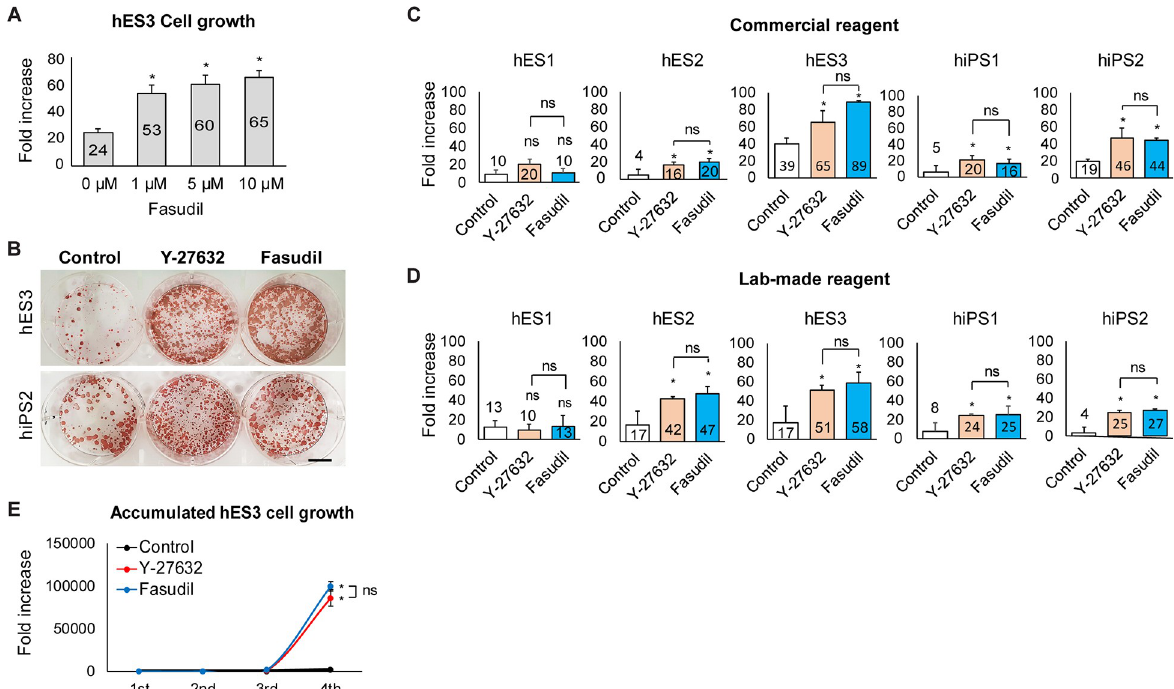
Fig 2. Fasudil enhances the cell growth of hPSCs. A: Growth of hES3 cells for 7 days according to fasudil concentration. The growth of hES3 cells at fasudil concentrations of 1, 5, and 10 μ M was concentration-independent, and significantly faster than the untreated control ( � : p < 0.05, 3 biological replicates). B: ALP staining of hES3 and hiPS2 cells cultured with Y-27632 or fasudil. Treatment with fasudil or Y-27632 increased the size of PSC colonies. Scale bar = 10 mm. C, D: Fold increase of initially seeded hESCs (hES1, 2, and 3) and hiPSCs (hiPS1 and 2) using commercial reagent C or lab-made reagent D. Growth of all hPSC lines except hES1 increased in response to fasudil or Y-27632 ( � : p < 0.05, 3 biological replicates). E: Increase of hES3 cell numbers with time. After three passages, treatment with fasudil and Y-27632 significantly increased cell numbers compared with the untreated group ( � : p < 0.05, 3 technical replicates). hPSC: human pluripotent stem cell, hES: human embryonic stem cell, ALP: Alkaline Phosphatase, hiPS: human induced pluripotent stem cell.